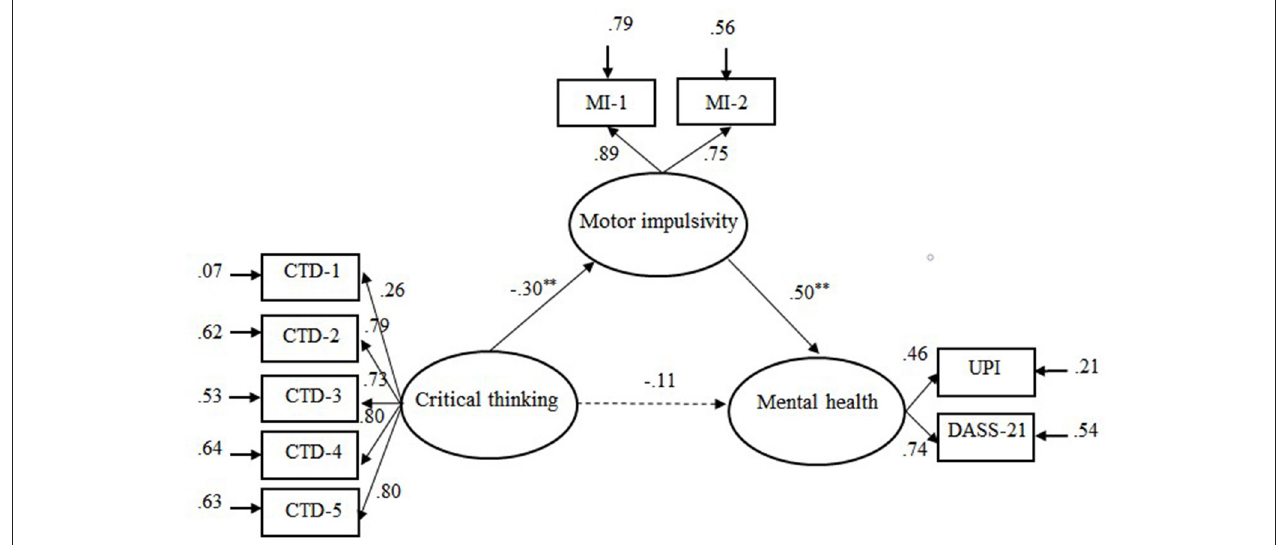
FIGURE 1 | Illustration of the mediation model: Motor impulsivity as mediator variable between critical thinking dispositions and mental health. CTD-l = Truth seeking; CTD-2 = Analyticity; CTD-3 = Systematically; CTD-4 = Self-confidence; CTD-5 = Inquisitiveness. MI-I and MI-2 were sub-scores of motor impulsivity. Solid line represents significant links and dotted line non-significant links. ** p < 0.01.